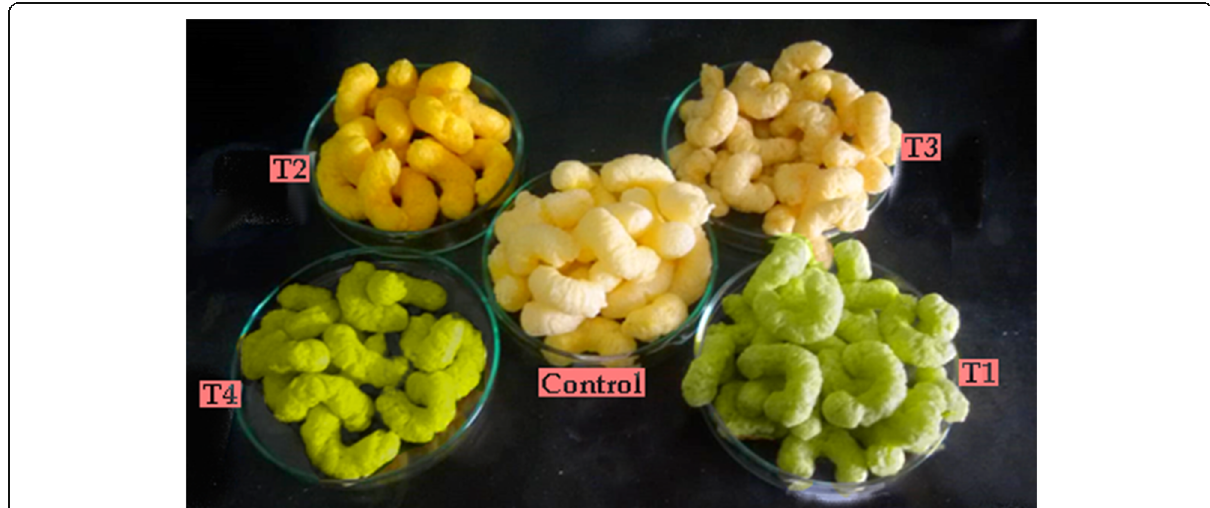
Fig. 1 Control: plain extruded product. T1, T2, T3 and T4: extruded corn product fortified with 3% (w/w) of laurel, turmeric, ginger and mixture formula contains 3% of the three herbs ’ mixture mentioned (1:1:1), respectively